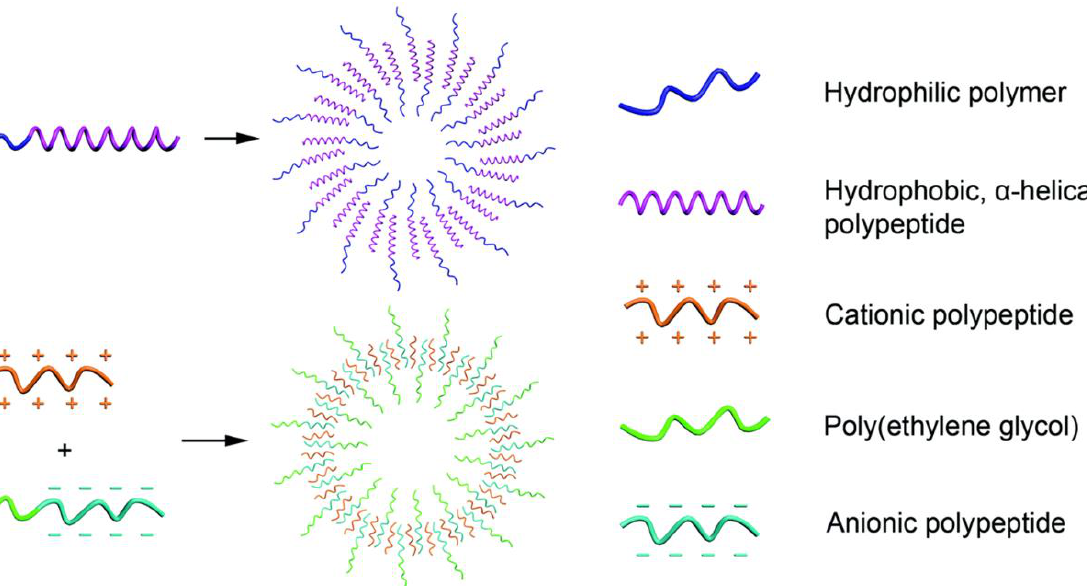
Figure 3. Schematic illustration of polypeptide vesicle formation. ( A ) a-helical polypeptide segments and ( B ) PVs from two polymers containing charged polypeptide segments with opposite charges. Reprinted with permission from Ref. [14]. Copyright: 2017, The Royal Society of Chemistry.